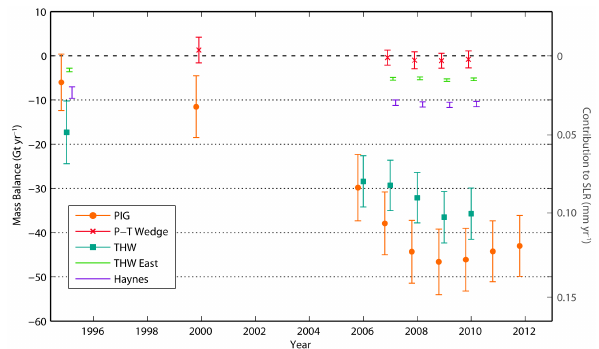
Figure 10. Mass balance history from 1994 to 2012 for each catch- ment. The mass balance was measured by subtracting the ice dis- charge measurements from various time intervals from Table 4 from the 1985–2009 mean catchment-wide accumulation from Table 3. The actual mass balance values are listed in Table 5. The points are offset slightly in time for clarity and do not represent actual differ- ences in the data collection